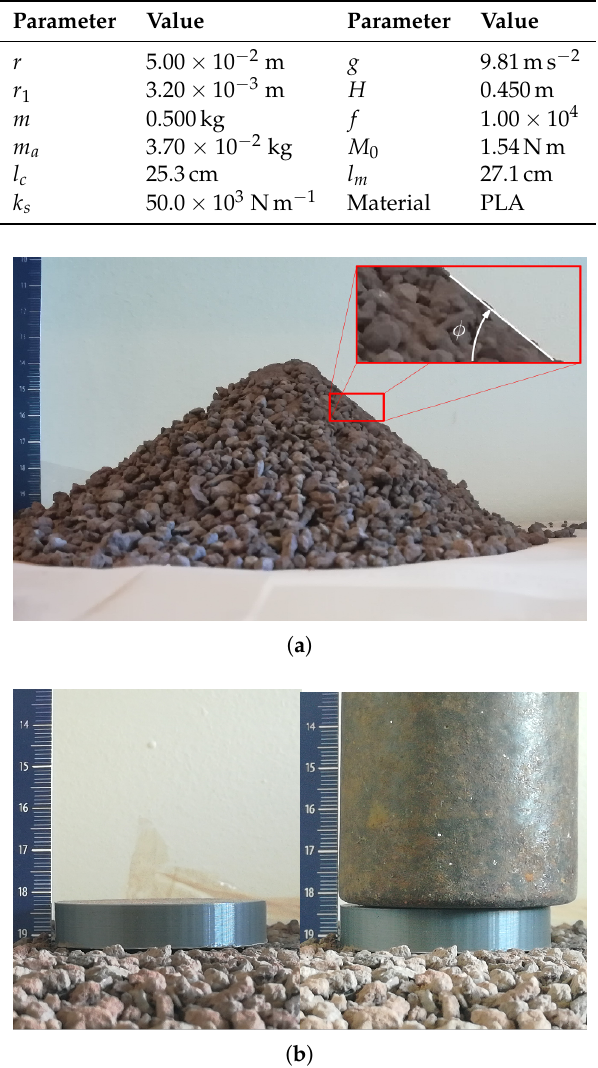
Table 1. Parameters used in the design of the lander.